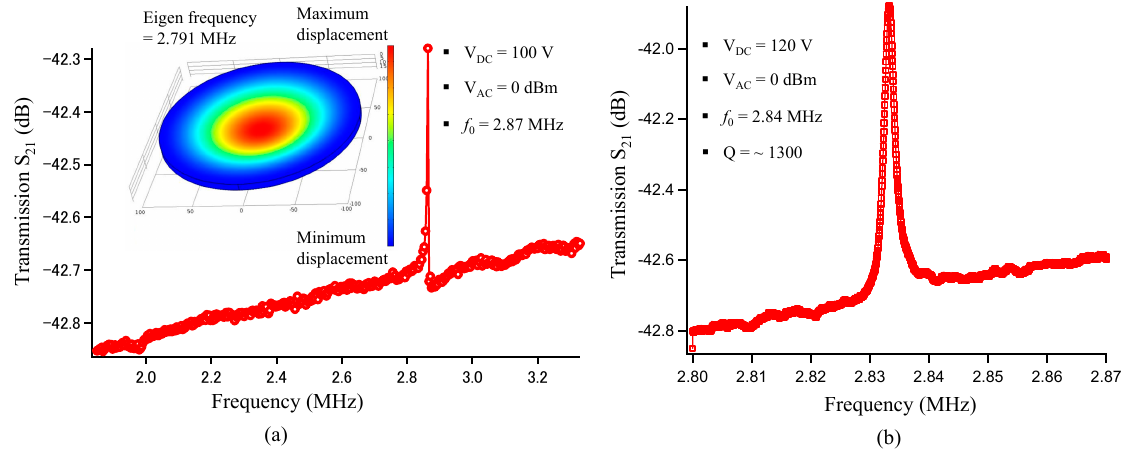
Figure 7. Simulation and measurement results. ( a ) Frequency response at V DC of 100 V with wide-range observation and FEM simulation; ( b ) Frequency response at V DC of 120 V with narrow-range